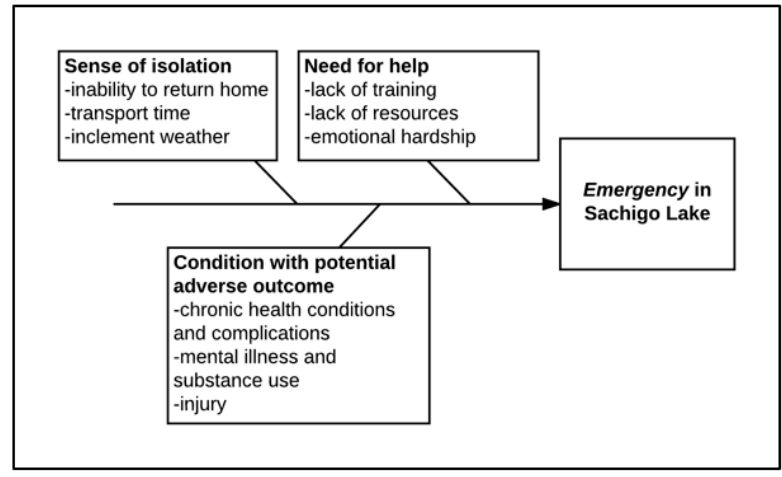
Figure 2. Framework for local perception of an emergency.